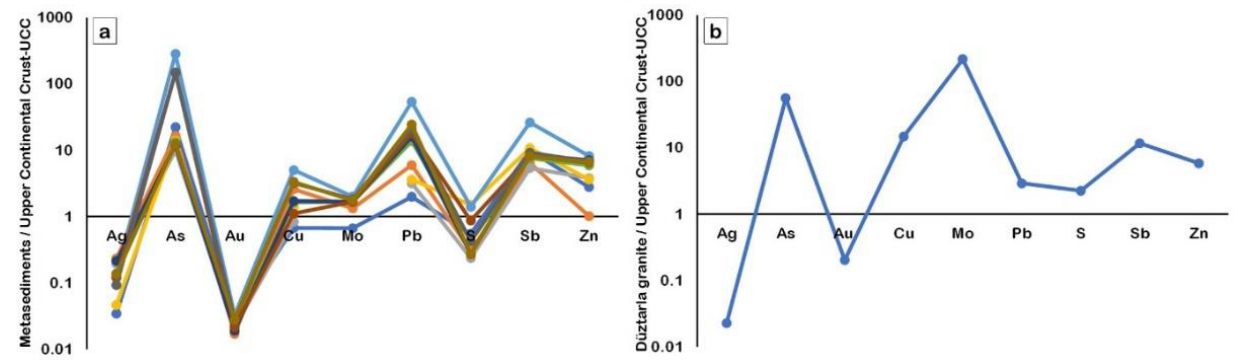
Figure 19. Upper continental crust (UCC) – normalized elements diagram of the metasediments ( a ) and Düztarla granitoid ( b ). After Taylor and McLennan [37] and Rudnick et al. [65].